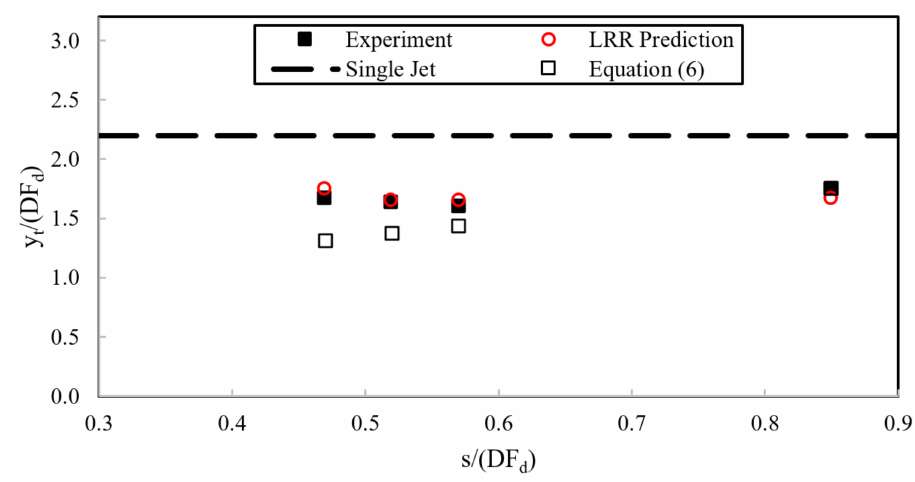
Figure 5. Experimental measurements [19] and numerical results of the normalized terminal rise height.